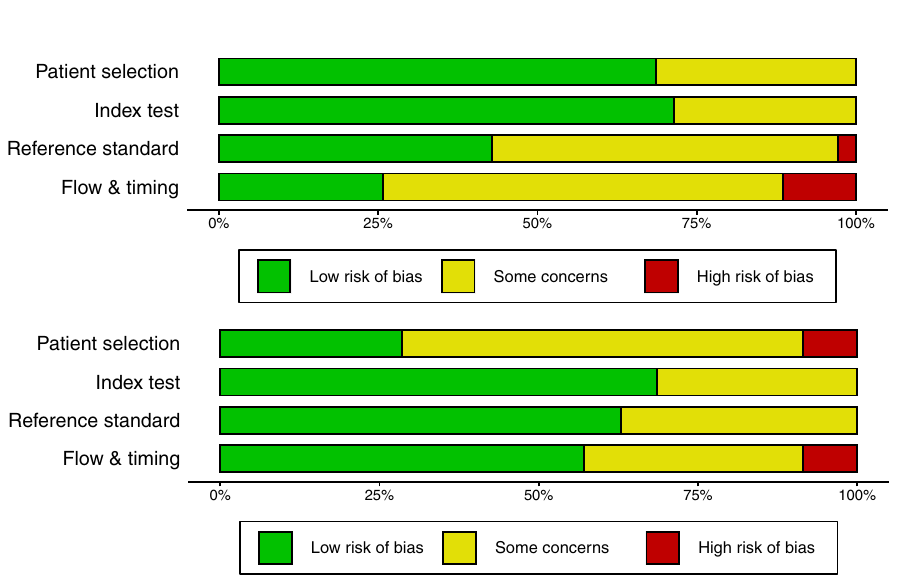
Table 3. Summary of identified studies using thermal imaging and VOC analysis as the screening modality.